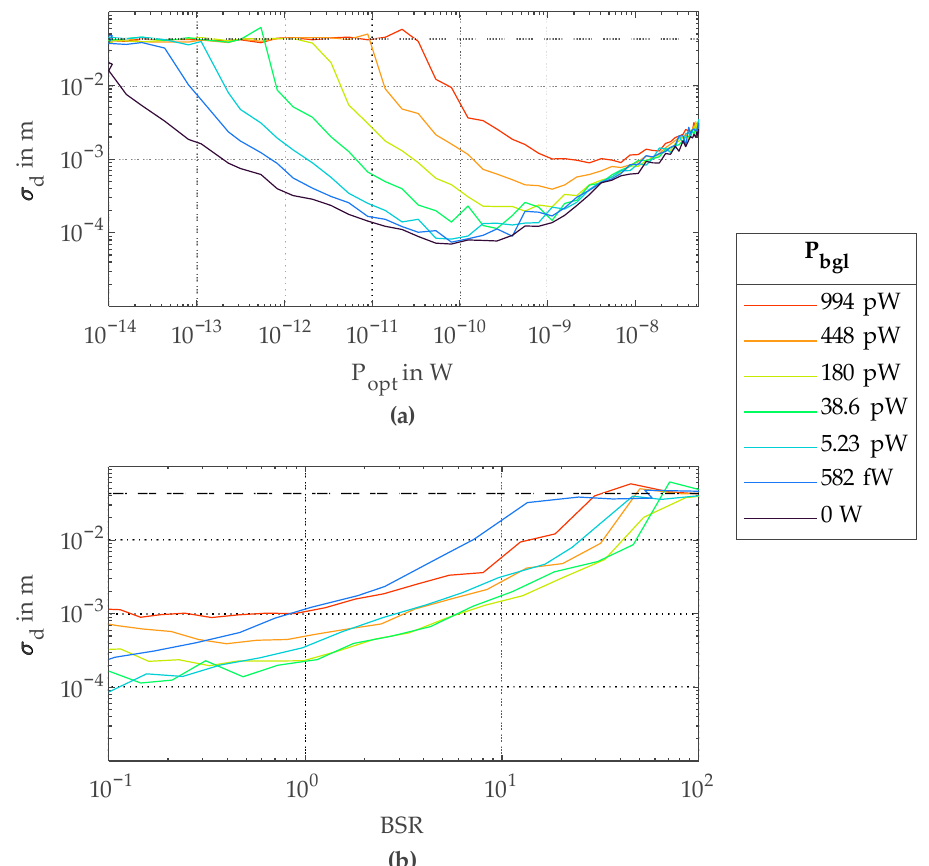
Figure 10. Measurements with added background light using 32 phase steps and a T int of 1.78 ms: ( a ) standard deviation σ d over P opt for different P bgl ; ( b ) standard deviation σ d over BSR for different P bgl .